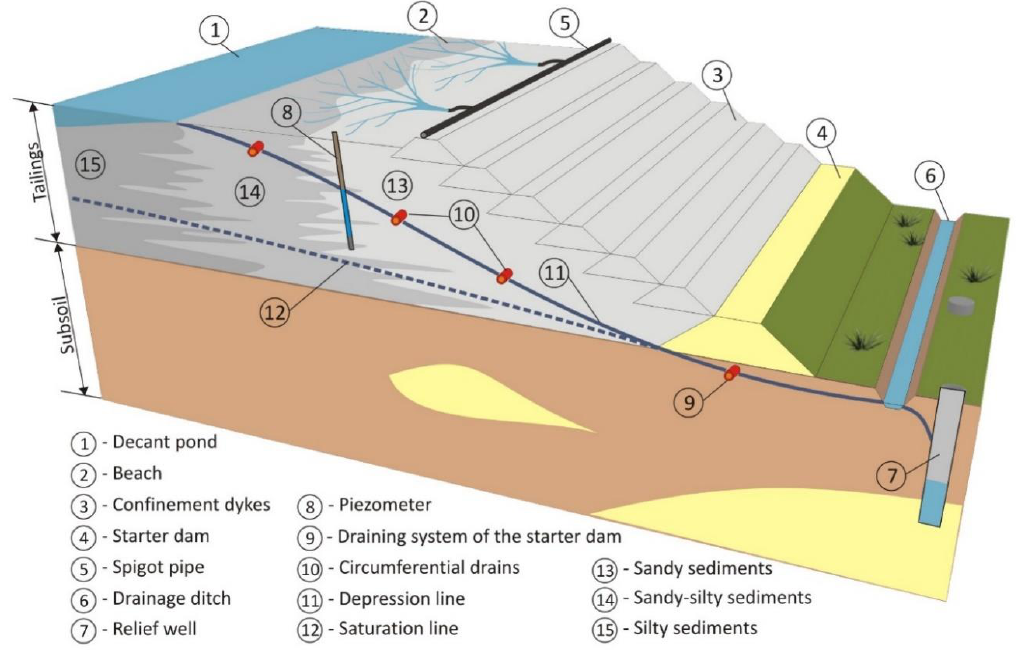
Figure 4. Schematic cross–section of ring dam and drainage system.